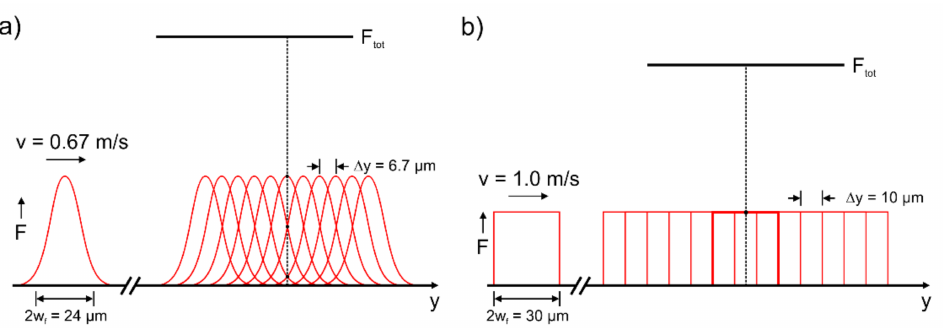
Figure 7. Overlap and contribution of individual pulses during scanning of a single line using ( a ) the Gaussian focal intensity distribution and ( b ) an ideal top-hat